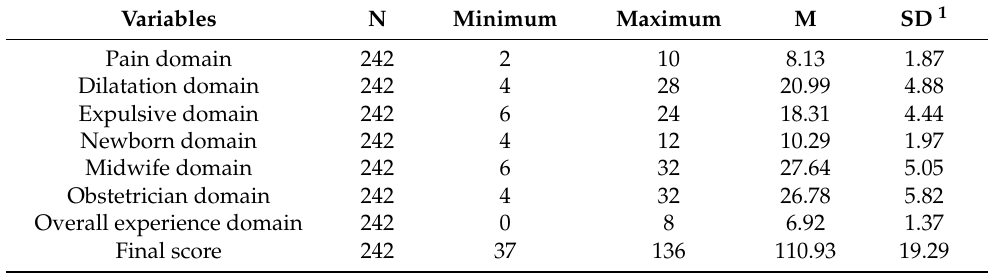
Table 2. Test domains and total score.